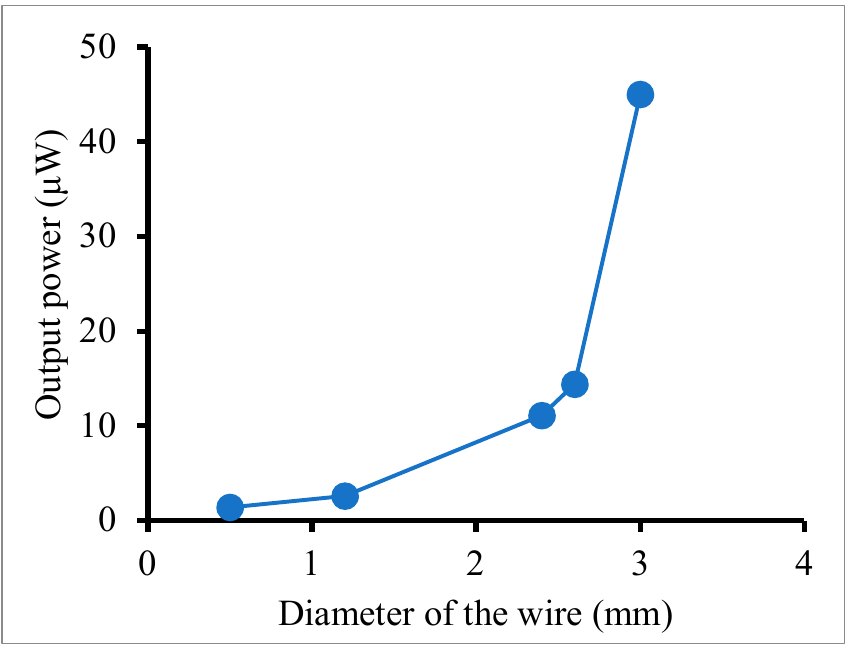
Figure 7. Output power with diameter of the antenna wire. Other parameters were constant. The speed of air, temperature, humidity, antenna gap, and height of the antenna were constant. The square-shaped antenna gap was 24 × 24 cm 2 .